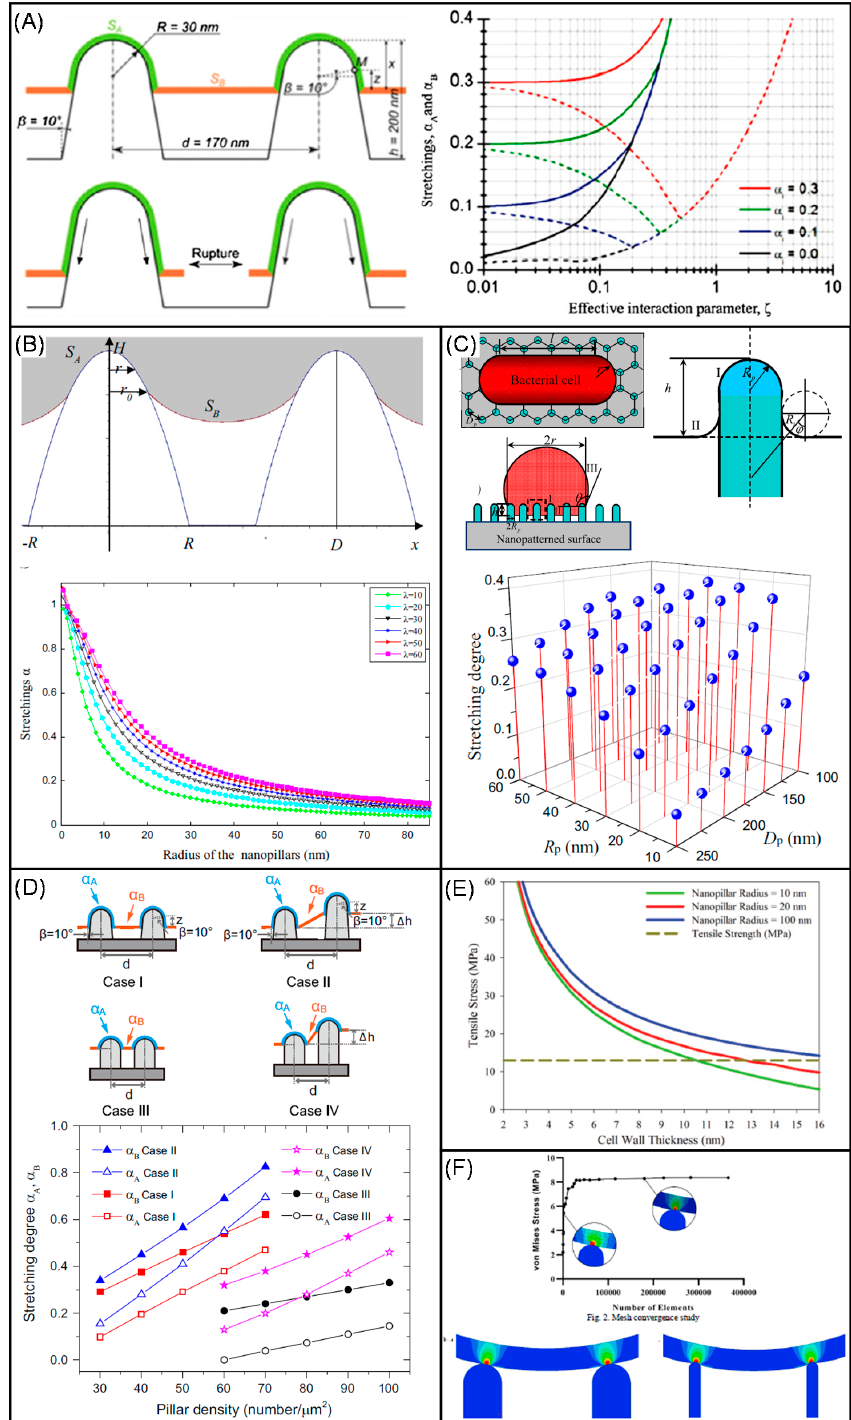
Figure 2. Current proposed theoretical models for the bactericidal mechanisms of nanotopographies analogous to those found on the cicada wing: ( A ) The first stretching model proposed by Pogodin et al. described rupturing of the cell membrane that was suspended between two adjacent nanopillars [reproduced with permission from Ref. [51]; ( B ) Xue et al. incorporated other geometric measurements of the nanopillars and parameters such as gravity and Van der Waals forces into the model. They found that stretching of the cell membrane increased as the radius of the nanopillars became smaller (i.e., sharper) [reproduced with permission from Ref. [52]; ( C ) Li et al. used a thermodynamic approach to calculate the free energy change of the stretched cell membrane when